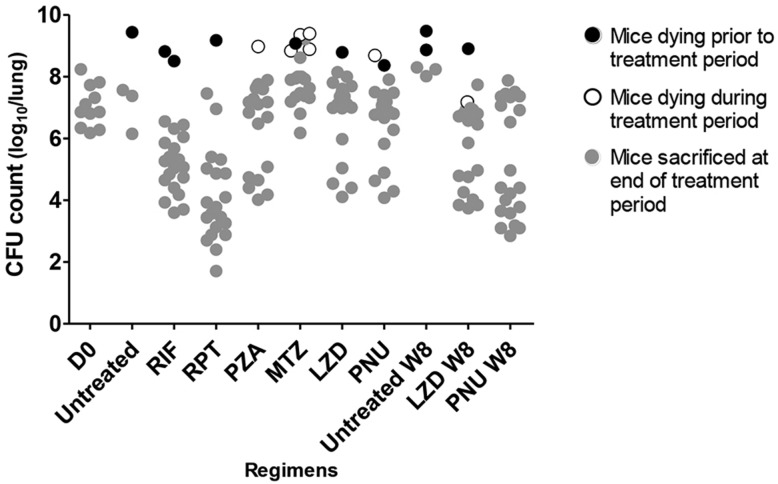
Lung CFU counts among C3HeB/FeJ mice. The treatment period was 4 weeks except in groups designated by ‘W8’, which received 8 weeks of treatment. Results from each incubation arm are combined. D0, initiation of treatment; RIF, rifampin; RPT, rifapentine; PZA, pyrazinamide; MTZ, metronidazole; LZD, linezolid; PNU, sutezolid.